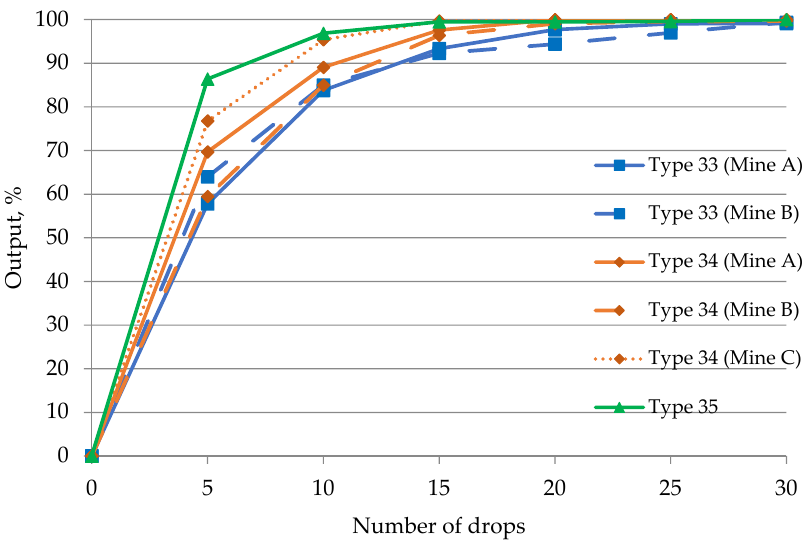
Figure 7. Comparative results of testing the susceptibility to crushing for the 33, 34, and 35 coal types—coal grains [43].